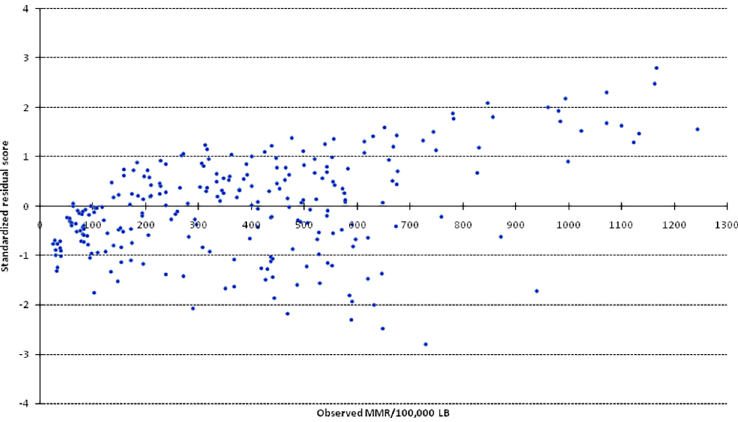
Fig 4. Standardized residual scores across different values of observed